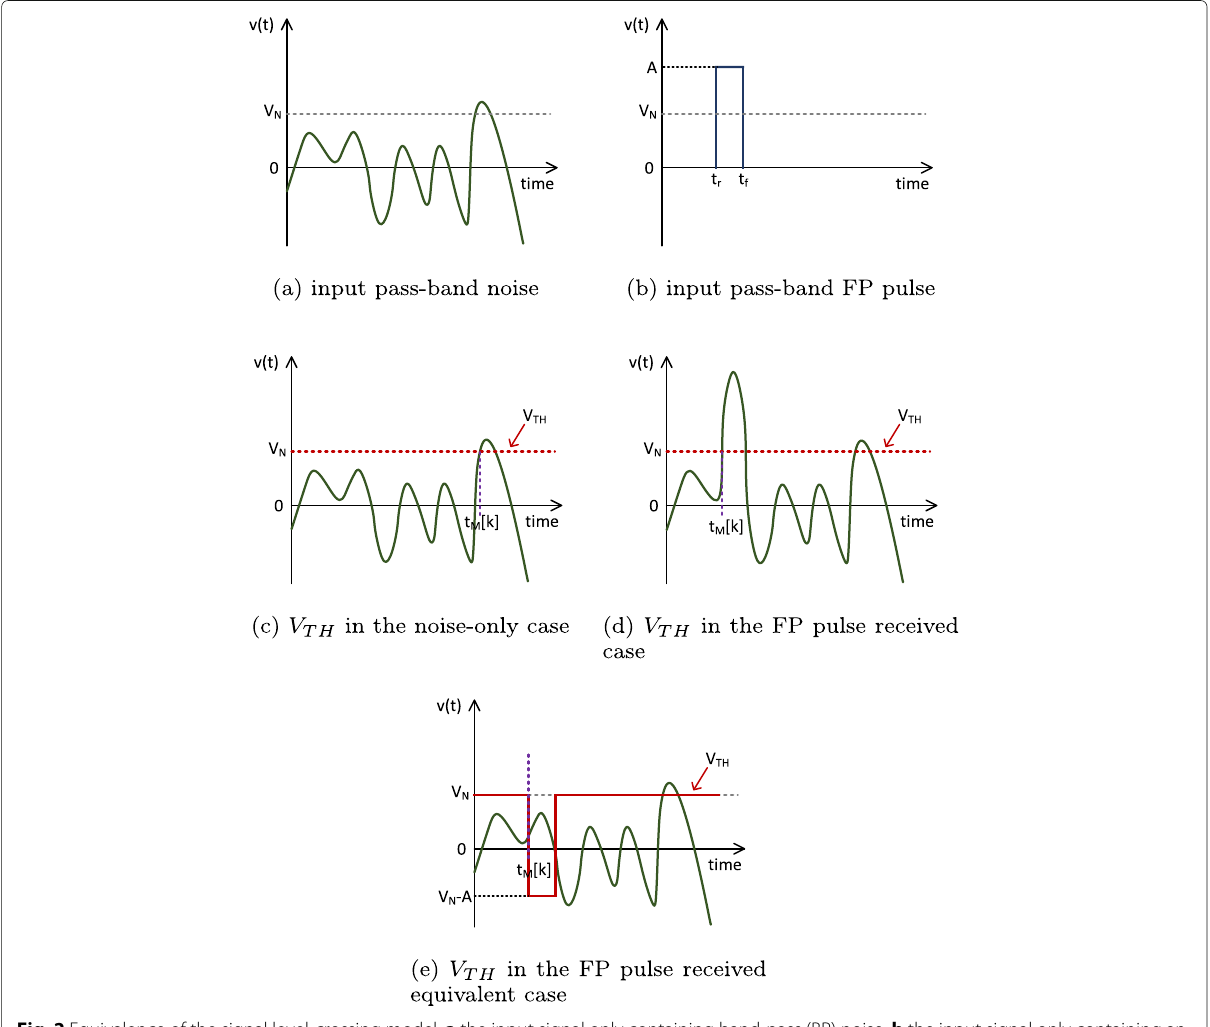
Fig. 2 Equivalence of the signal level-crossing model: a the input signal only containing band-pass (BP) noise, b the input signal only containing an FP pulse, c a threshold crossing due to BP noise only with V N = V TH , d A threshold crossing when the input is the summation of BP noise and an FP pulse with V N = V TH , e is the equivalent model of ( d ), where the input signal contains only BP noise while V TH changes to V N − A during an FP pulse